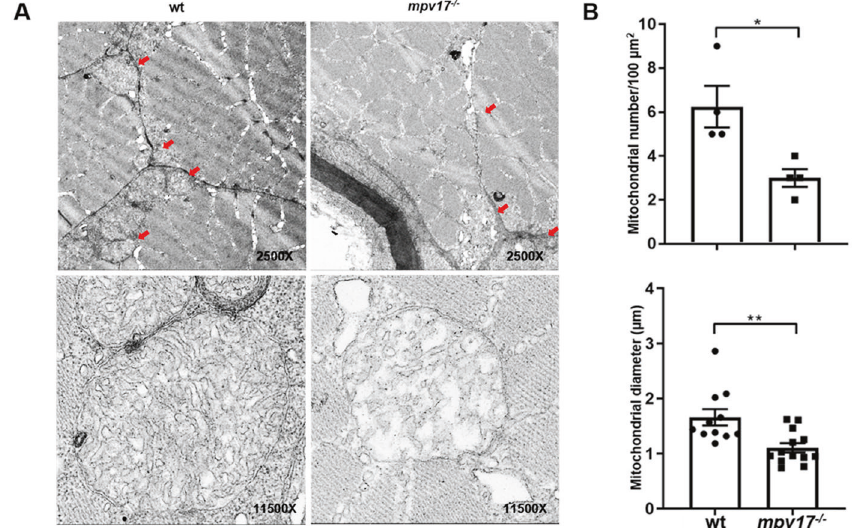
Fig. 6 The mitochondria structure, number, and size in the mpv17 − / − larvae muscle. A TEM image of the skeletal muscle for the larvae at 7 dpf. The magni fi cation was ×2500 in the upper panel and ×11,500 in the lower panel. Red arrowhead indicated the mitochondria in the skeletal muscles. B The number of the mitochondria per 100 μ m 2 (upper) and the diameter of the mitochondria in the skeletal muscle (lower). Error bars were indicated with ±SEM, * p < 0.05 and ** p < dramatically decreased the surface area of the inner-membrane the mpv17 − / − larvae muscles were signi fi cantly decreased, system, which is the most important place for cellular respiration. compared to the wild-type larvae (Fig. 6A, upper panel, Fig. 6B, Thus, the low content of ATP may be due to the defects of the upper panel). In each 100 μ m 2 of the tissue, the average number mitochondrial cristae. of mitochondria was about 6 and 3 in the wild-type and mpv17 − / − larvae, respectively. The size of the mitochondria in mpv17 − / − larvae was smaller than that of the wild-type (Fig. 6B, lower panel). DISCUSSION The mitochondria were shrunk about 30% of the size in the In this study, the mpv17 knockout zebra fi sh was generated mpv17 − / − line. We also saw the hollow mitochondria with broken using the CRISPR/Cas9 system. The mpv17 − / − zebra fi sh showed cristae in the mpv17 − / − larvae muscle (Fig. 6A). These defects